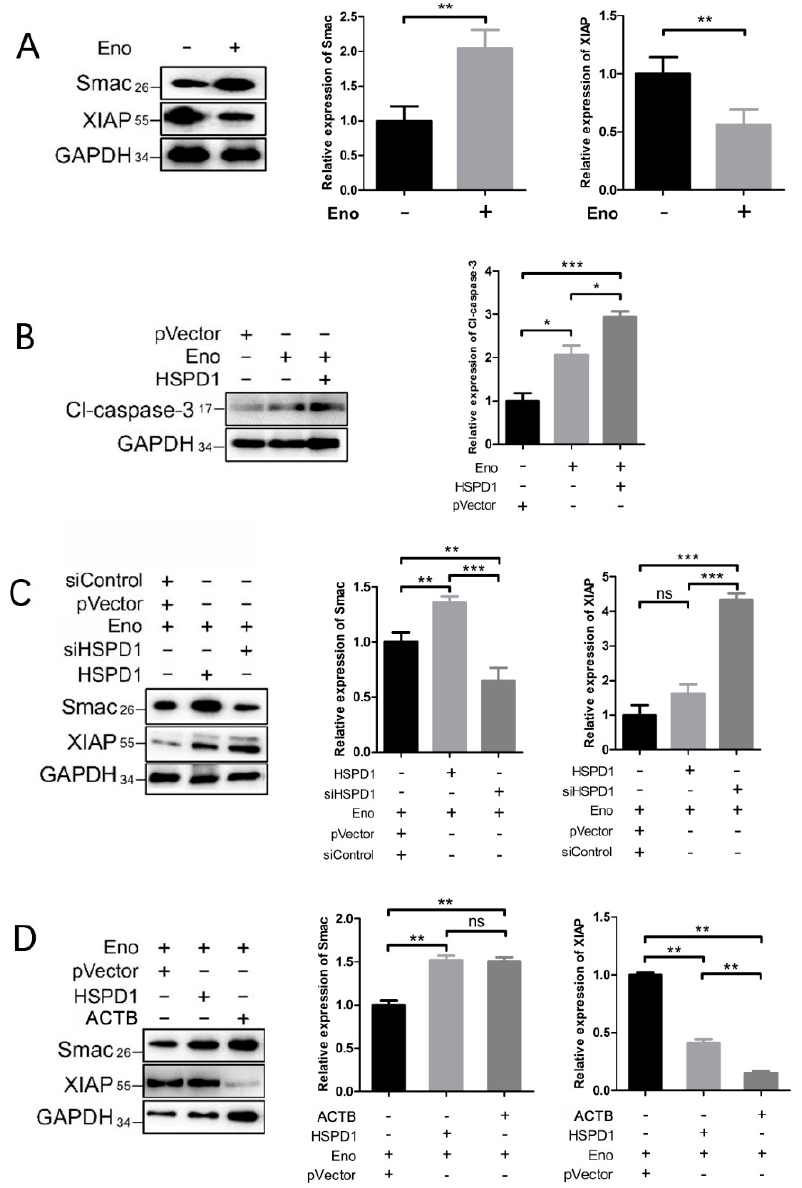
Figure 6. Interacting proteins HSPD1 and ACTB induce apoptosis via the Smac-XIAP-caspase-3 pathway. All Eno groups (Eno +) were treated with Eno for 24 h, and protein expression levels were determined by Western blotting. ( A ) Smac and XIAP expression levels after Eno treatment alone. ( B ) The cl-caspase-3 expression after Eno treatment alone or combined with HSPD1 overexpression. ( C ) Smac and XIAP expression levels after Eno treatment alone or combined with HSPD1 overex- pression/knockdown. ( D ) Smac and XIAP expression after Eno treatment alone or combined with HSPD1/ACTB overexpression. (Eno +, 293T cells treated with Eno for 24 h; HSPD1 +, overexpression of HSPD1 in 293T cells by transfection of pCMV-3 × FLAG-HSPD1; ACTB +, overexpression of ACTB in 293T cells after transfection of pEGFP-ACTB; siHSPD1 +, knockdown of HSPD1 in 293T cells by transfection of HSPD1-siRNA; pVector and siControl are the negative controls for overexpression and knockdown, respectively) (Smac: Second mitochondria-derived activator of caspases; XIAP: X-linked inhibitor of apoptosis protein; Cl-caspase-3: cleaved caspase-3) (ns, p ≥ 0.05; *, p < 0.05; **, p < 0.01; ***, p < 0.001)